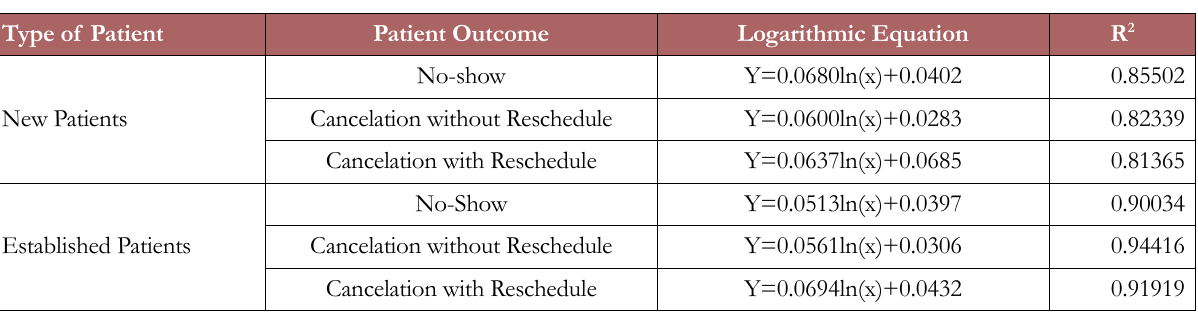
Table 2. Characteristics of the best-fit function from Figure 1. Source: prepared by the authors based on hospital data